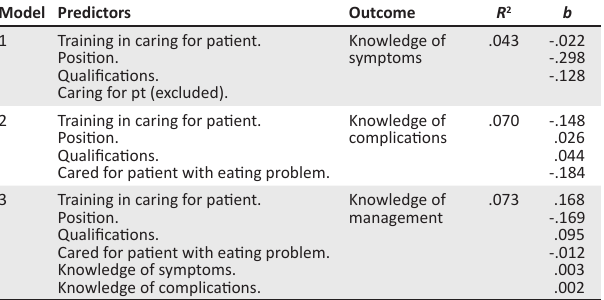
TABLE 5: Regression analysis of variables regressed onto participants’ knowledge of dysphagia. Model Predictors Outcome R 2 b